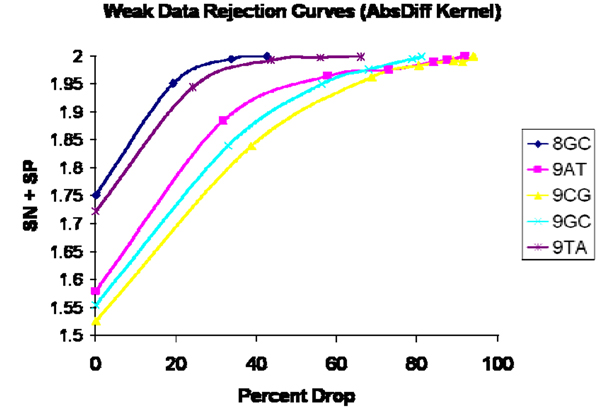
The Percentage Data Rejection vs SN+SP curves are shown for test data classification runs with a multiclass discriminator. The following criterion is used for dropping weak data: for any data point xi; if maxm{fm(xi)} ≤ Confidence Parameter, then the data point xi is dropped. For this data set using AbsDiff kernel (σ2 = 0.2) performed best, and a confidence parameter of 0.8 achieve 100% accuracy.